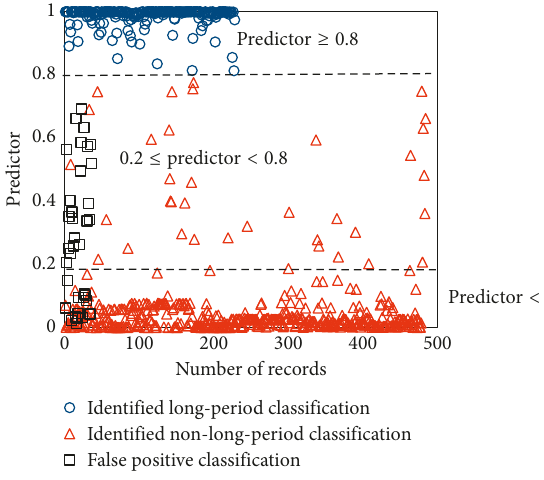
Figure 11: Distribution of predictors.